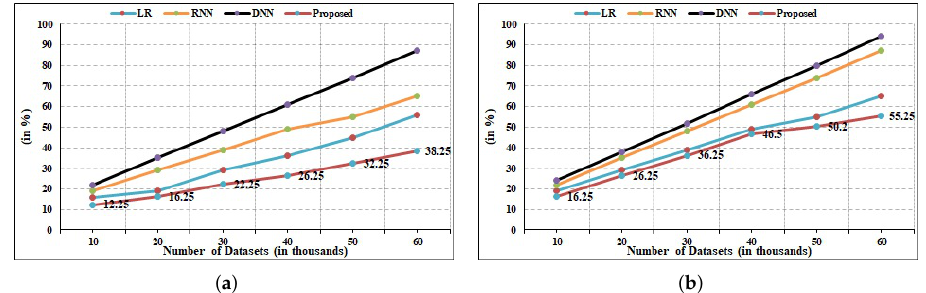
Figure 7. Energy Consumption Analysis. ( a ) GRU-Model 1, ( b ) GRU-Model 2.